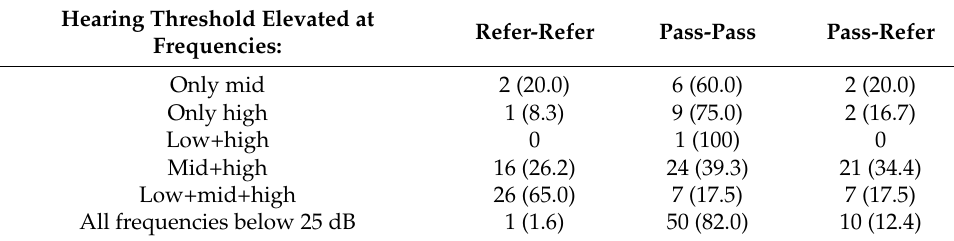
Table 3. Agreement between both Accuscreen devices in ears with hearing thresholds above 25 dB in low and/or mid and/or high frequencies. Number of ears (and percent values) are